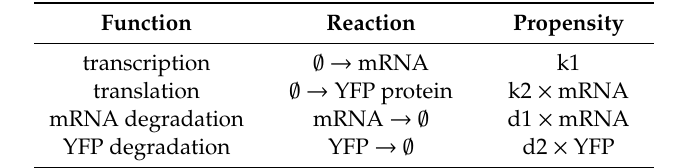
Table A4. Equation